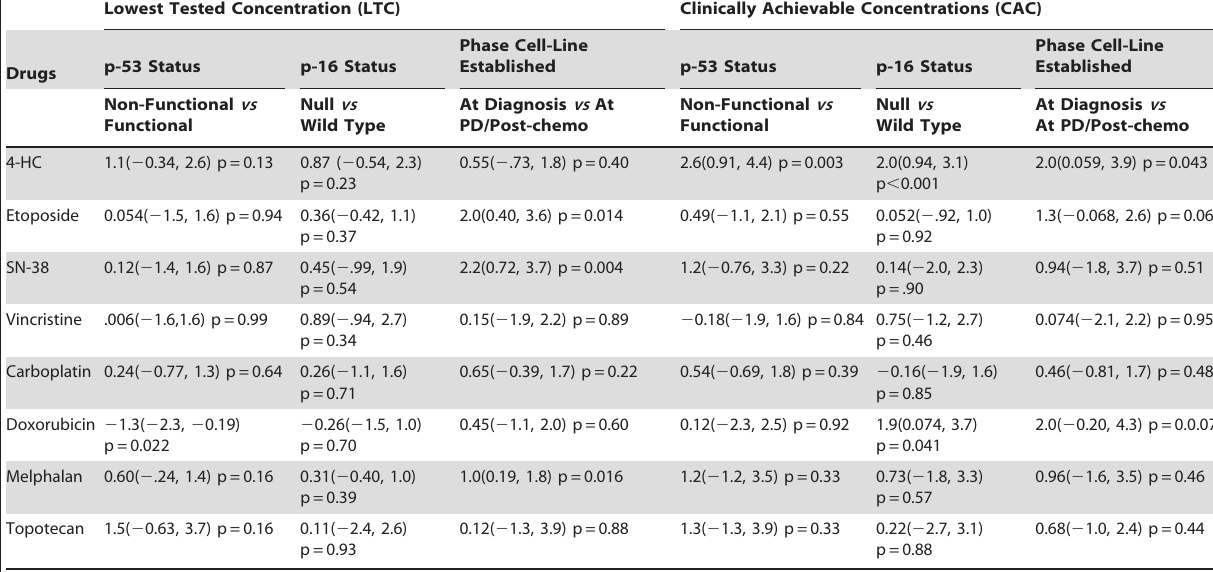
Table 5. Differences and significance at lowest tested concentration (LTC) and clinically achievable concentration (CAC) in numbers of logs of cell kill between p53 non-functional vs. functional cell lines, between p16/14 null vs. wild lines, and between lines established at diagnosis vs. those established at PD or